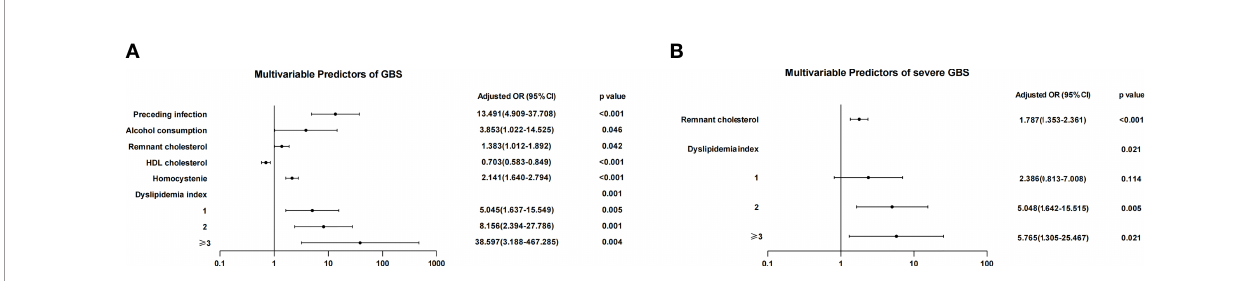
FIGURE 2 | Logistic regression analysis of the risk of GBS and severe GBS. (A) After adjusting for multiple factors, preceding infection, alcohol consumption, remnant cholesterol, Hcy and the dyslipidemia index were independent risk factors for GBS. As the dyslipidemia index increased, the OR value increased. (B) Remnant cholesterol and a dyslipidemia index of 2 or ≥ 3 were independent risk factors for severe